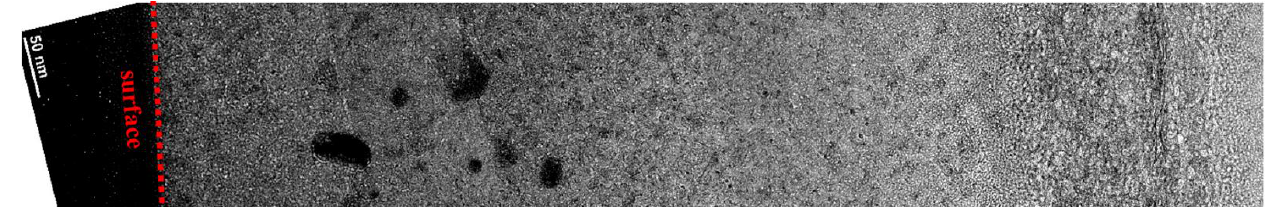
Figure 7. Detailed TEM observation of the whole damage region in the sample with 1.0 × 10 18 ions/cm